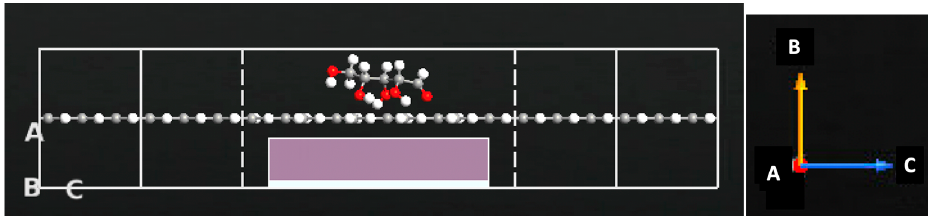
Figure 3. Sugar molecules’ atomic structure: ( a ) xylose, ( b ) glucose, and ( c ) fructose. Color code: oxygen-red, hydrogen-white, carbon-gray.